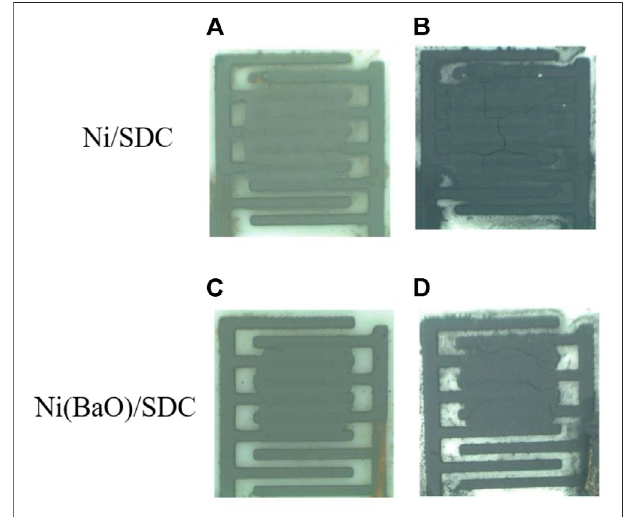
FIGURE7| AppearanceofthesurfacesoftheNi/SDCandNi(BaO)/SDC fi lms formed on a comb-type Au electrode by EPD after H (C) and after further CH 4 exposure (B) and (D) .